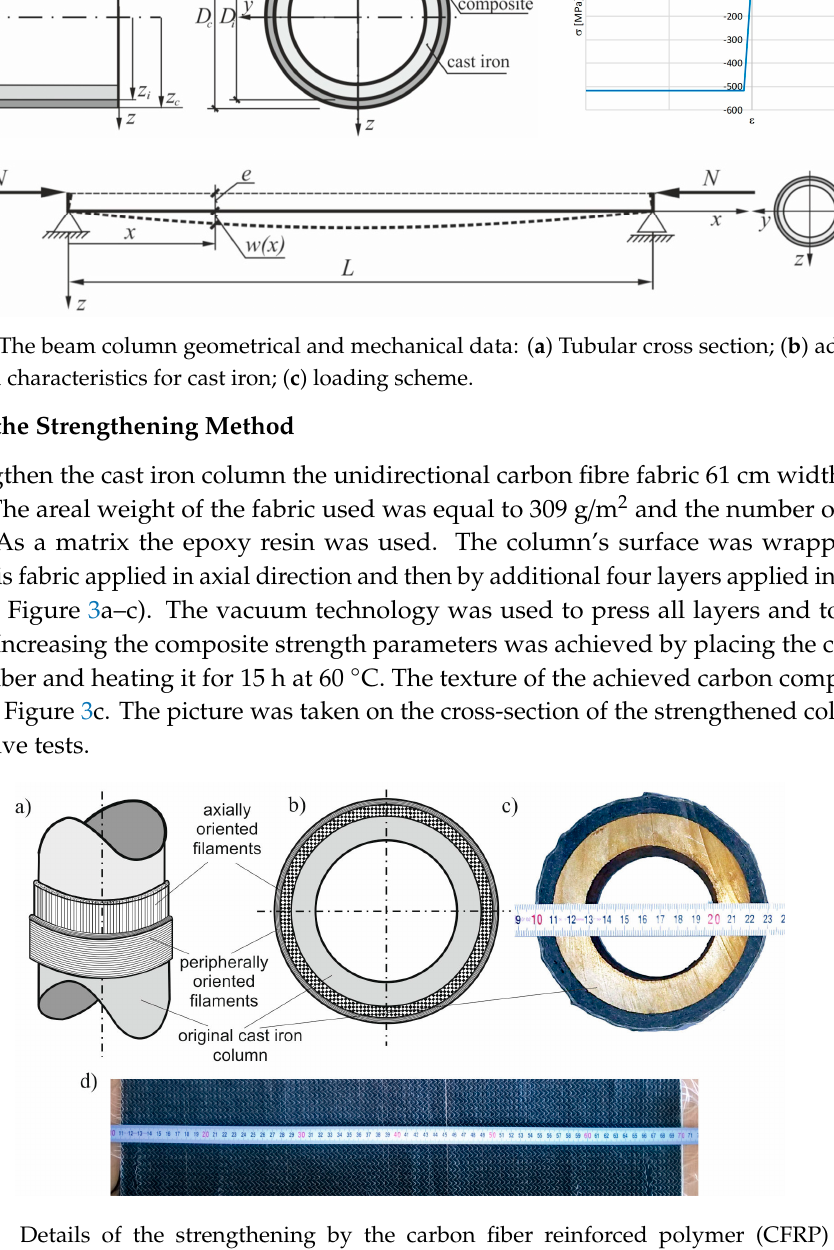
Table 1. Geometrical and material parameters.